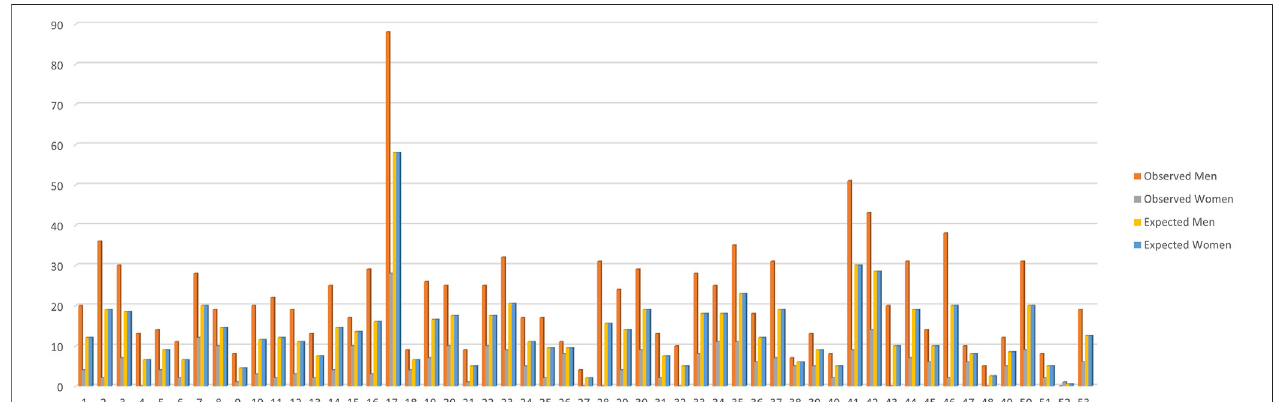
FIGURE 7 | Observed/expected values by gender of the composition of the editorial board and editor(s)-in-chief for each journal.